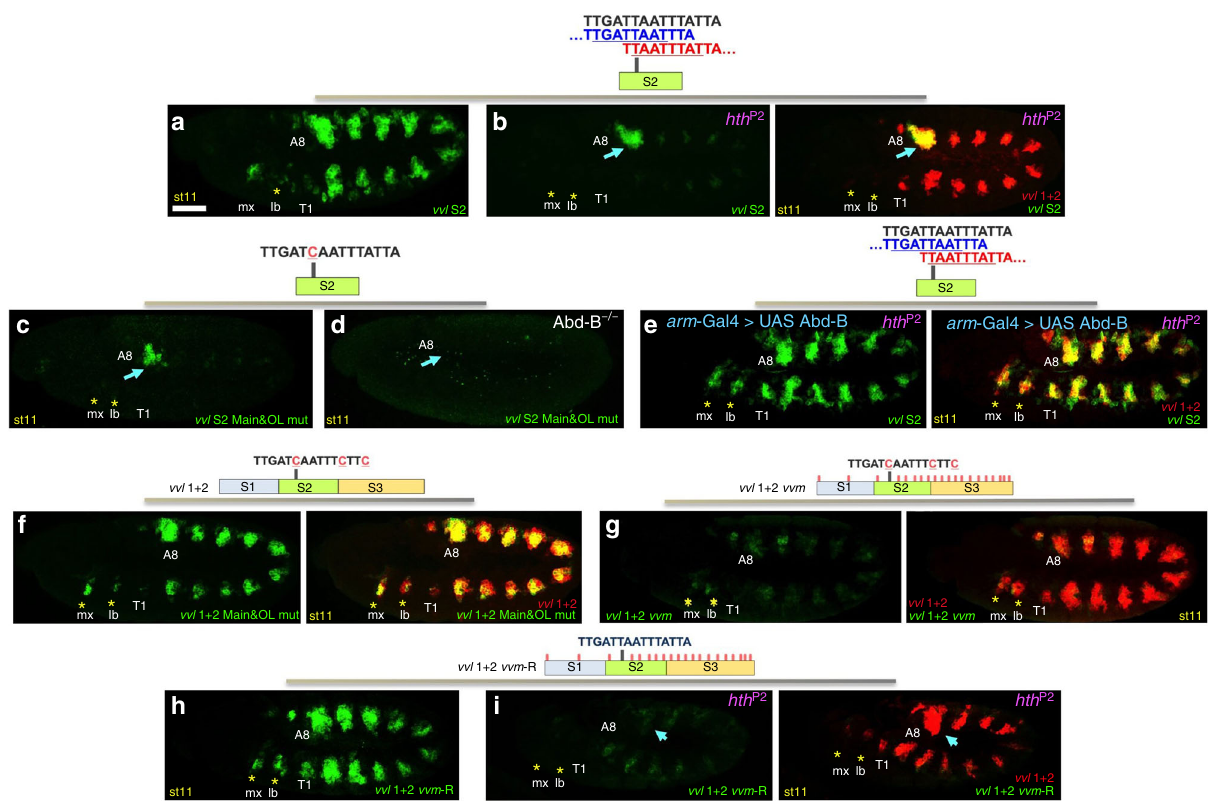
Fig. 5 Relative requirement of Hox-cofactor vs. Hox-monomer sites in the vvl1 + 2 and S2 reporters. a Expression driven by the S2 reporter (green) in wild type or in ( b ) hth P2 embryos. ( b , right panel) shows the differential effect absence of cofactor function causes in S2 with respect to vvl1 + 2 (red). Blue arrow points to A8 expression, which is maintained in both reporters, asterisks label the lack of expression in the maxilla and labial segments. Main and overlapping sites are present in both reporters. c The expression of S2main&OL mut , an S2 variant with a single base change mutating both main and overlapping sites is restricted to the A8 segment. d In Abd-B M1 homozygous embryos, the expression of the S2main&OL mut reporter disappears from A8. e The expression of S2 in hth P2 mutant embryos is restored by the ectopic Abd-B expression in the ectoderm to similar levels as those of vvl1 + 2 ( e , red in right panel). f The expression of vvl1 + 2main&OL mut , a vvl1 + 2 reporter variant where the main and overlapping Hox-cofactor sites have been mutated, decreases in most segments, except A8, to similar levels as those observed in vvl1 + 2 hth P2 mutant embryos. g Expression of the vvl1 + 2vvm reporter (green) where most Hox input is absent compared to vvl1 + 2 ( g , right panel). h Expression of the vvl1 + 2vvm-R reporter (green) where the main and overlapping Hox-cofactor sites have been restored. i Expression of the vvl1 + 2vvm-R reporter (green) in a hth P2 mutant embryo showing the loss of most expression, including that in A8 (arrow) compared to the effects on vvl1 + 2 (i, red in right